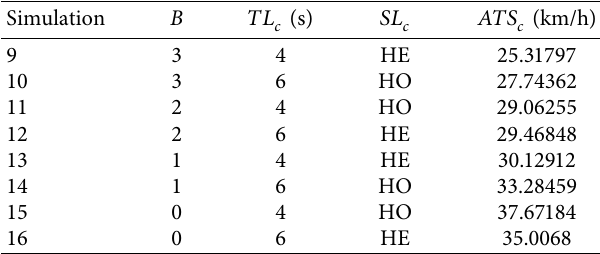
Table 7: Sorting TS in clusters of SL Simulation